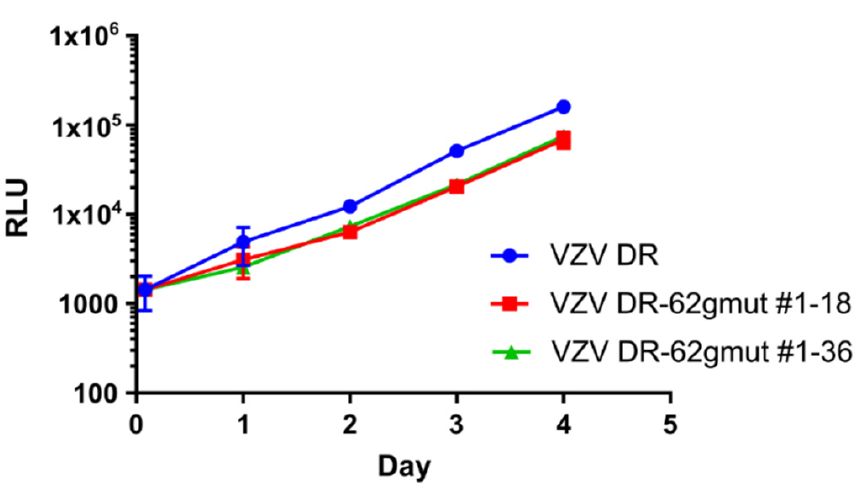
Figure 4. VZV DR-62gmut grows similarly to WT VZV. Naïve ARPE19 cells were infected